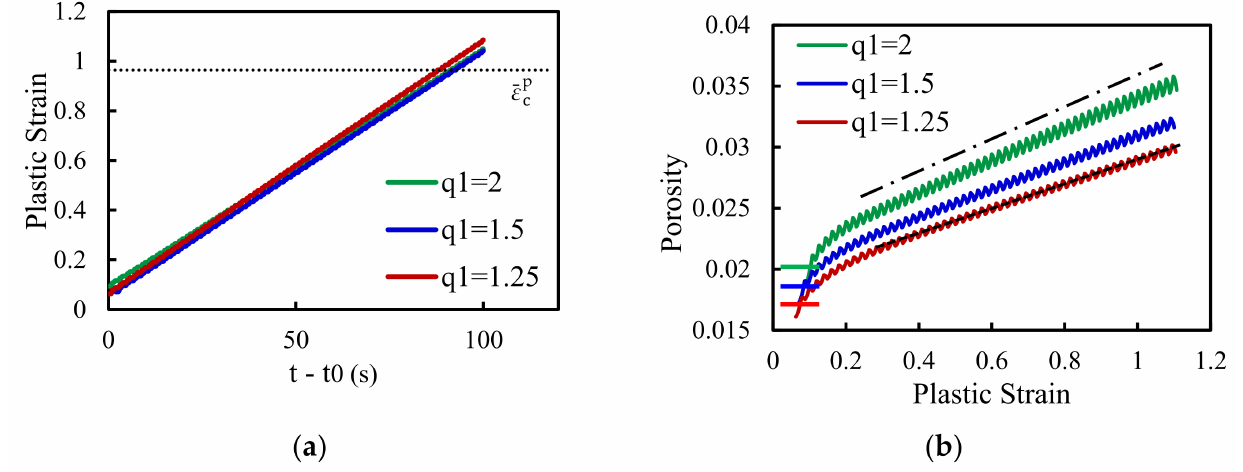
Figure 9. ( a ) Plastic strain evolution for distinct values of q 1 . The q 1 = 2 curve is almost indistinguishable because it is overlapped by the others. ( b ) Porosity evolution due to the increase in plastic strain. Results are shown in natural